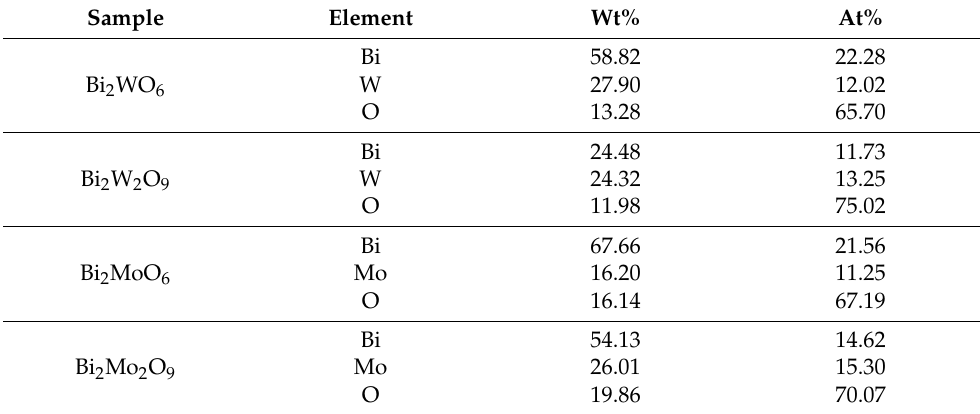
Table 1. EDX data of Bi 2 WO 6 , Bi 2 W 2 O 9 , Bi 2 MoO 6 and Bi 2 Mo 2 O 9